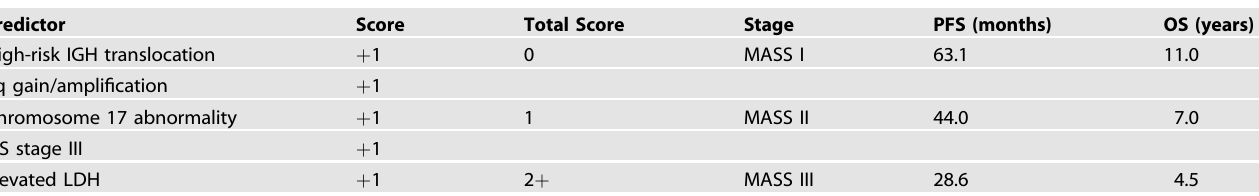
Table 4. MASS – Mayo Cohort.